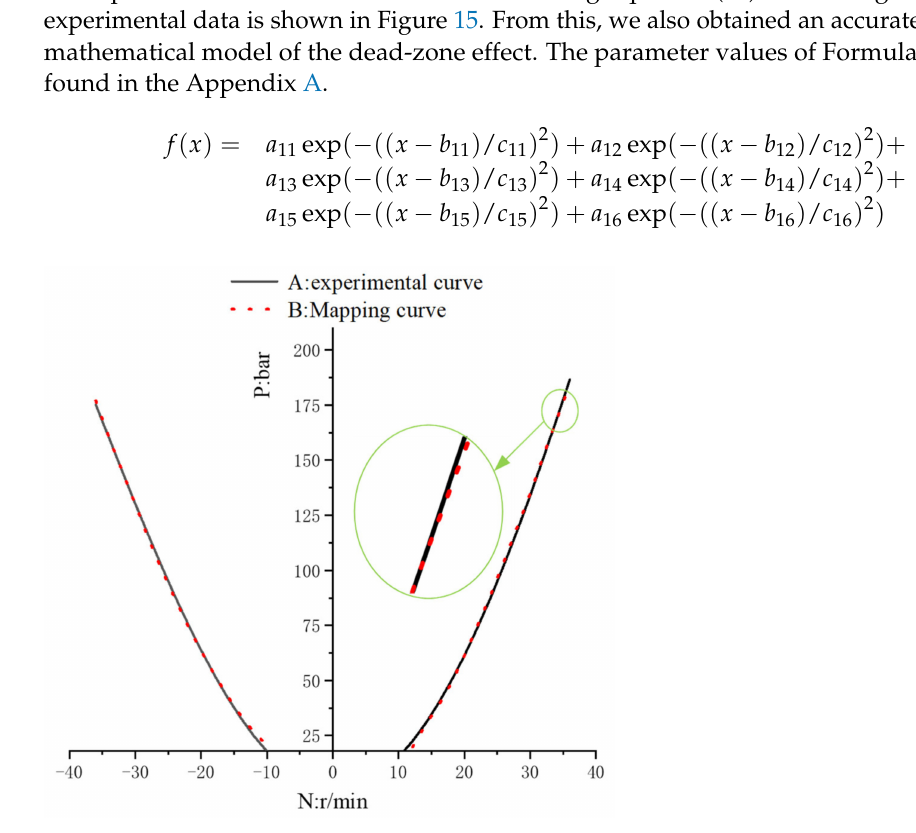
Figure 15. Dead-zone build pressure mapping.